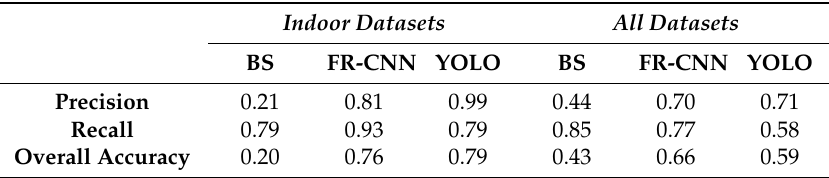
Table 5. Overall accuracy